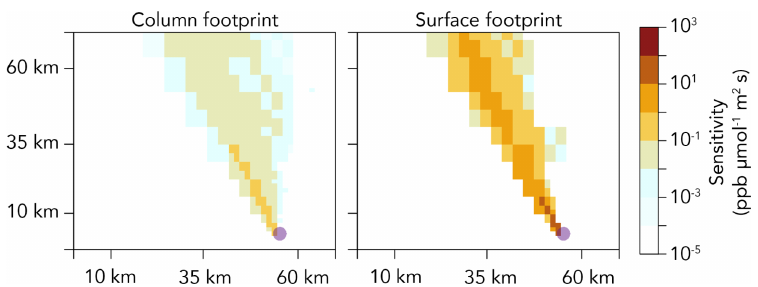
Figure 3. Sample sensitivities of observed atmospheric concentrations (column and surface) to surface emissions upwind, defining the emission footprint for that observation. Values are shown here for a particular observation point (purple dot) and time (19 October 2013 at 09:00LT). Concentrations are in mixing ratio units ofppb (dry column mean mixing ratio for the column) and emissions are in units of µmolm − 2 s − 1